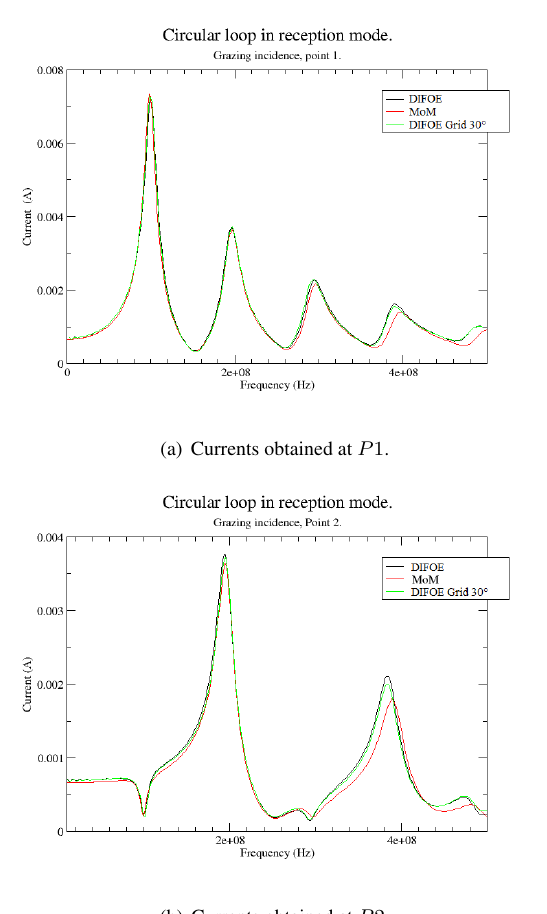
Figure 12: Comparison between the solutions obtained with our method, FDTD and